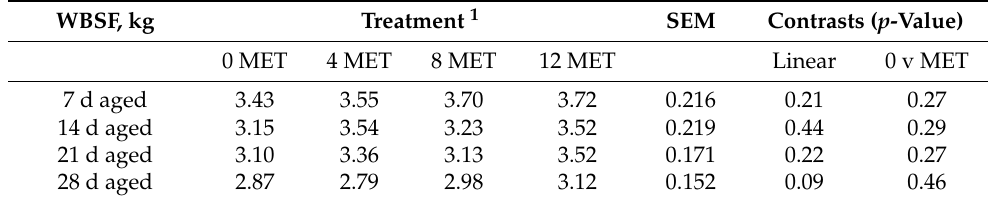
Table 6. Effects of encapsulated methionine (MET) supplementation on Warner–Bratzler Shear Force (WBSF)